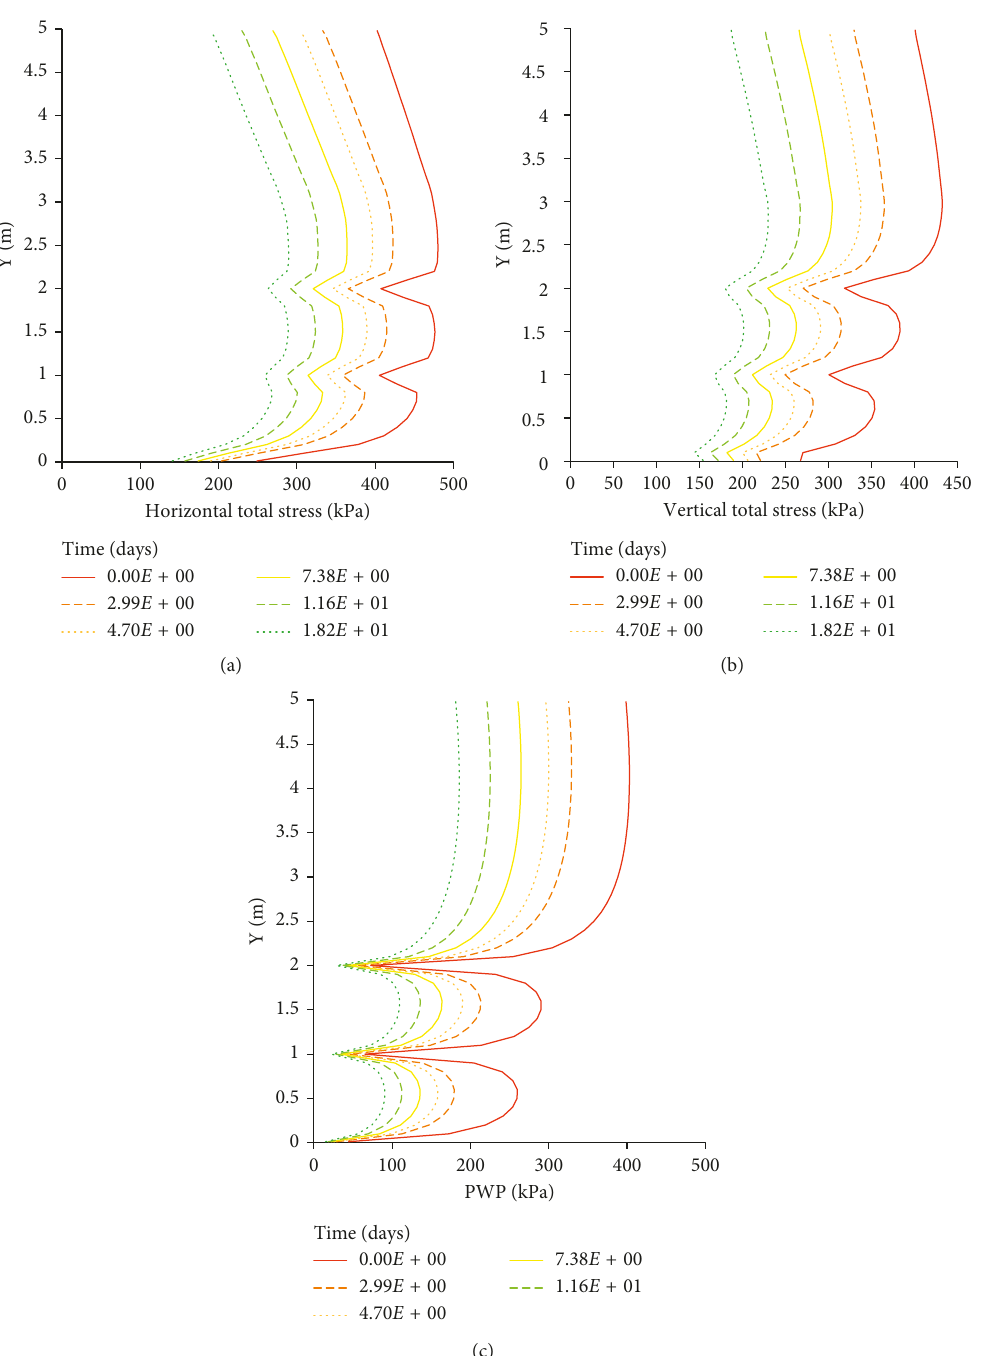
Figure 8: Evolution of the (a) horizontal ( σ h ) and (b) vertical ( σ v ) total stresses and (c) PWP ( u w ) along the height of the barricade after the end of stope filling operation for the reference case (see the details in Table 1, Case